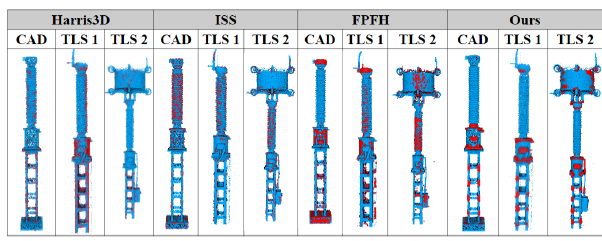
Figure 11. Qualitative comparison of keypoint extractors against ours on industrial pieces. Keypoints are represented in red.